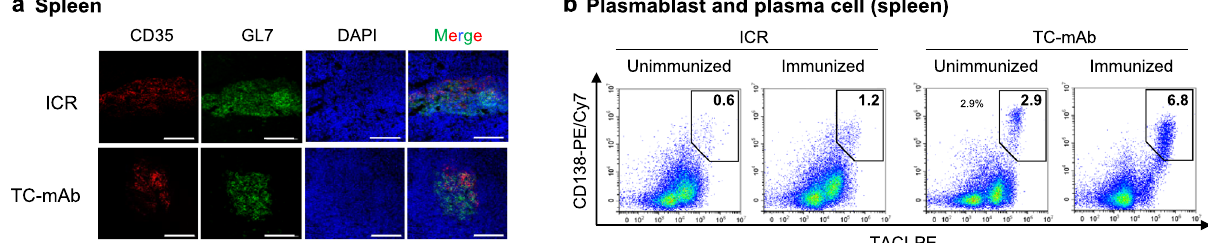
Fig. 9 Analysis of spleen cells in repeatedly immunized mice for monoclonal antibody production. a Representative images of fl uorescence immunohistochemistry. The spleens of OVA-immunized TC-mAb mice were harvested and analysed by immunohistochemistry. Sections were stained for follicular dendritic cells (CD35, red), GC B cells (GL7; green) and nuclei (DAPI, blue). The images were taken at ×20 magni fi cation. All scale bars indicate 100 μ m. Representative fi gure from two independent experiments is shown. b Flow cytometry of plasmablasts/plasma cells (CD138 + TACI + ). Each spleen sample was collected after the seventh and fi nal booster steps of immunization (in mice of ~21 weeks old). Gating strategies and all gating panels of plasmablast and plasma cell subsets are presented in Supplementary Figs. 38 and